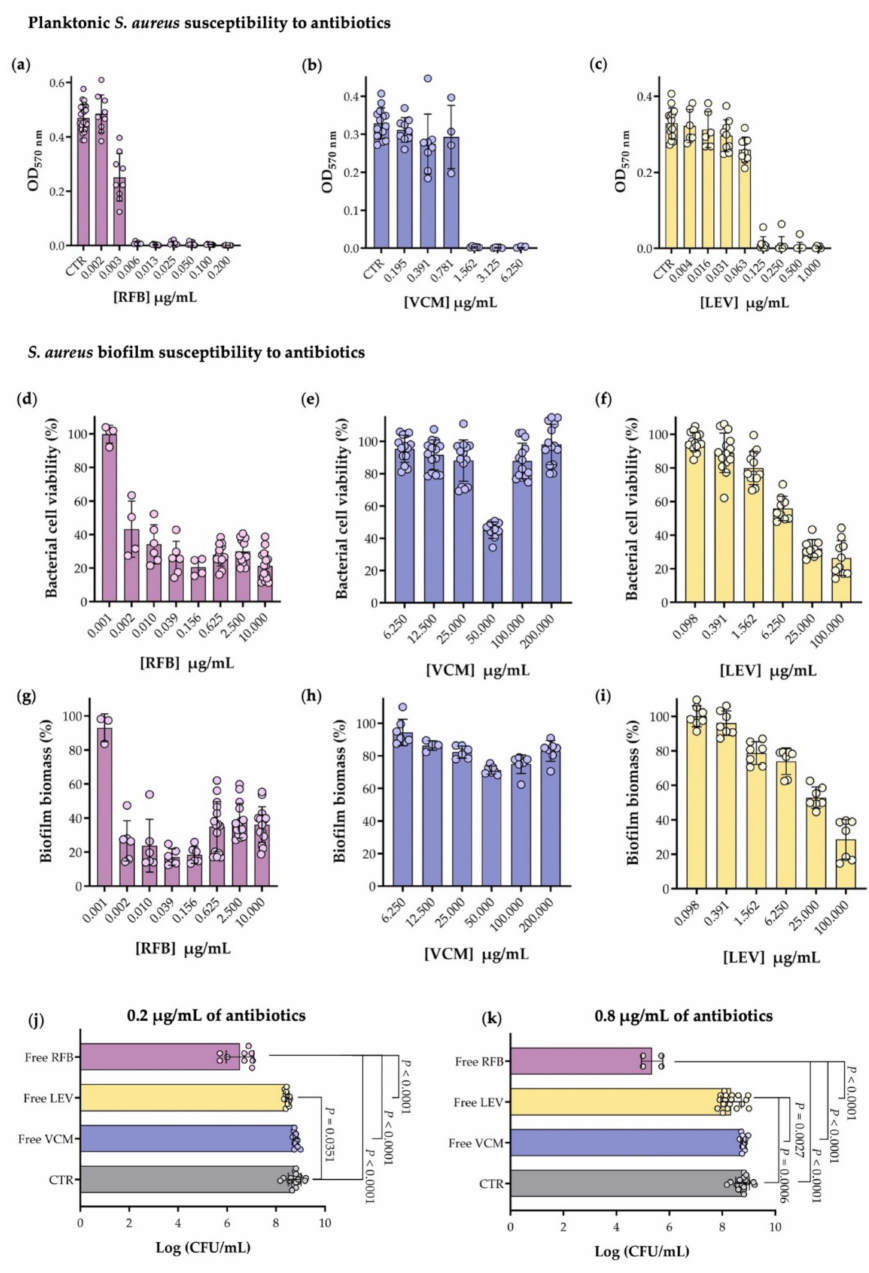
Figure 2. ( a – c ) In vitro planktonic MSSA susceptibility to free antibiotics assessment through broth microdilution method followed by turbidity measurement (OD 570 nm ), after 24 h of incubation. The negative control corresponds to planktonic MSSA in MHB (CTR). Antibiotic concentrations of ( a ) RFB (0.002–0.200 µ g/mL), ( b ) VCM (0.195–6.250 µ g/mL) and ( c )